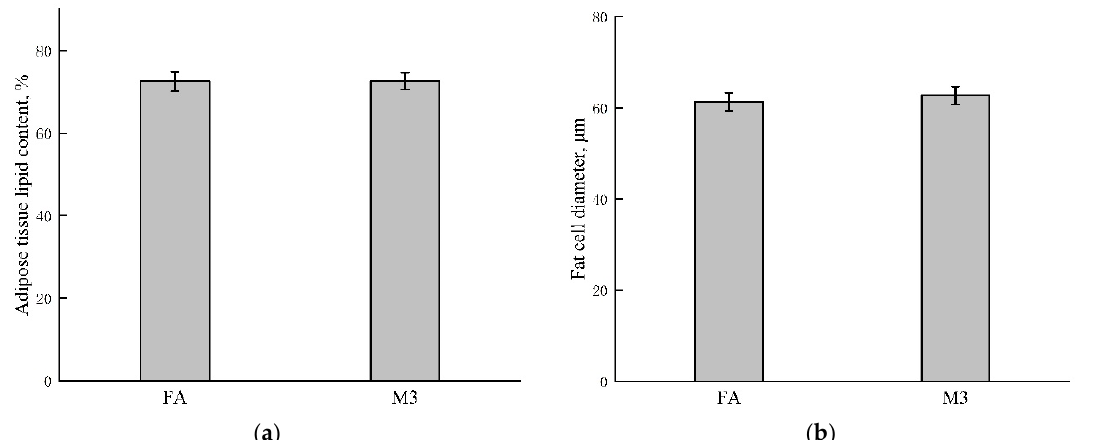
Figure 1. ( a ) Effects of feeding frequency on adipose tissue lipid content; ( b ) Effects of feeding frequency on fat cell diameter. FA, pigs had free access to feed; M3, pigs were given three meals per day (06:00, 14:00, and 22:00 h).